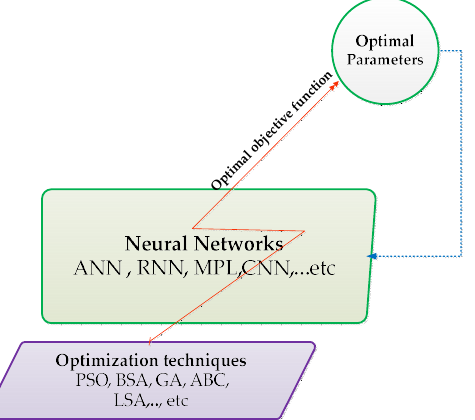
Figure 1. Methodology of utilizing optimization to find optimal parameters of neural networks.